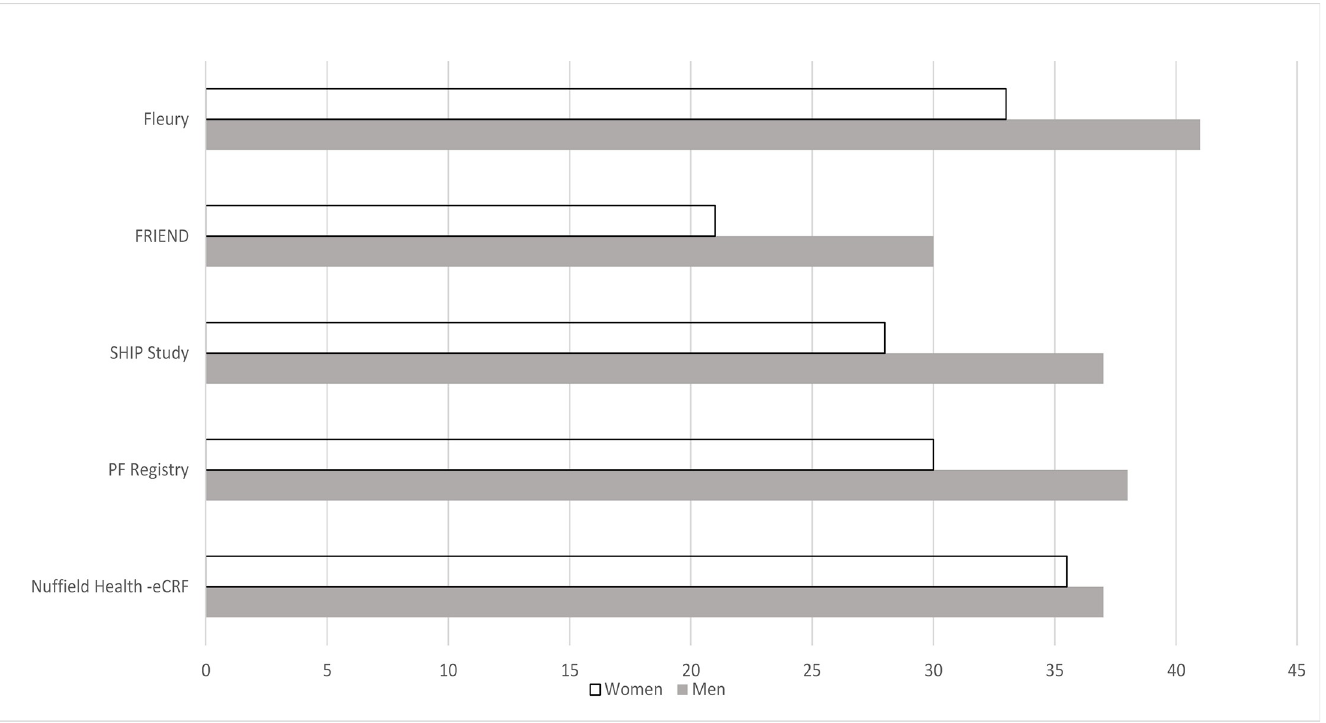
Fig 3. Comparative values of normative aerobic fitness data (peak VO 2 in ml � kg -1 � min -1 ) from Nuffield Health (estimated CRF) and other registry findings including Fleury, FRIEND, SHIP, and PF Registry for a 45-year-old male and female in the 50 th percentile range.